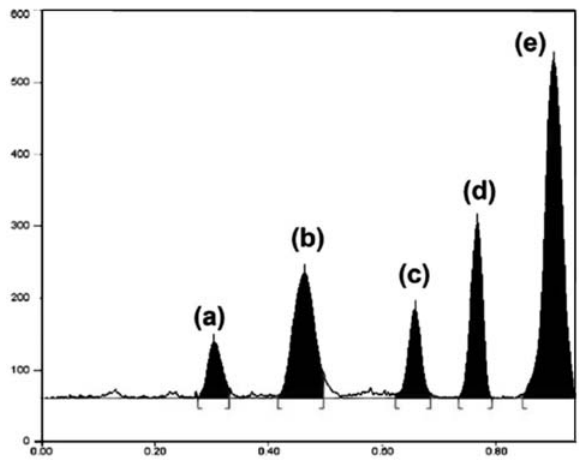
Figure 3: Separation of drugs from degradates and impurities with different Rf values (a) FAM acidic degradate 0.34 Rf (b) Ibuprofen